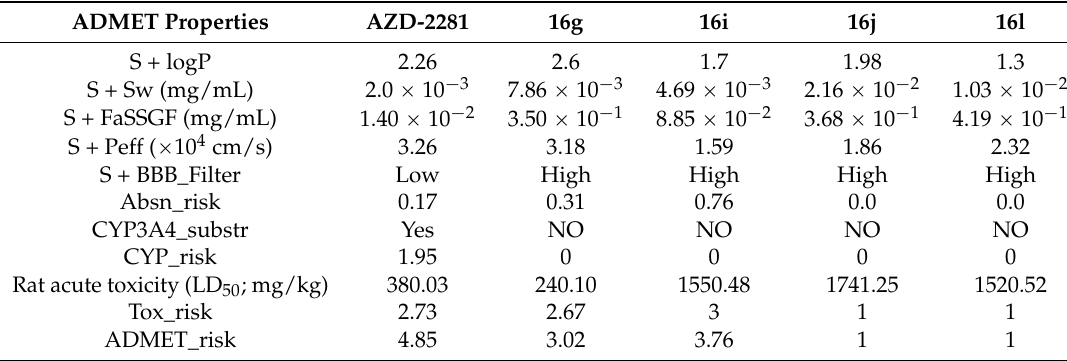
Table 4. Selected ADMET properties of compounds.